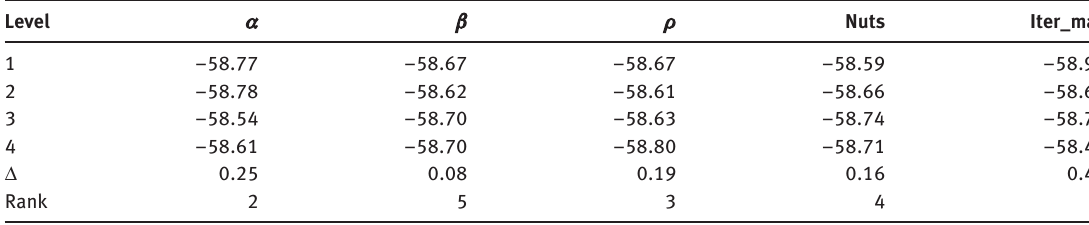
Table 4: Analysis of SNR (Smaller is Better).